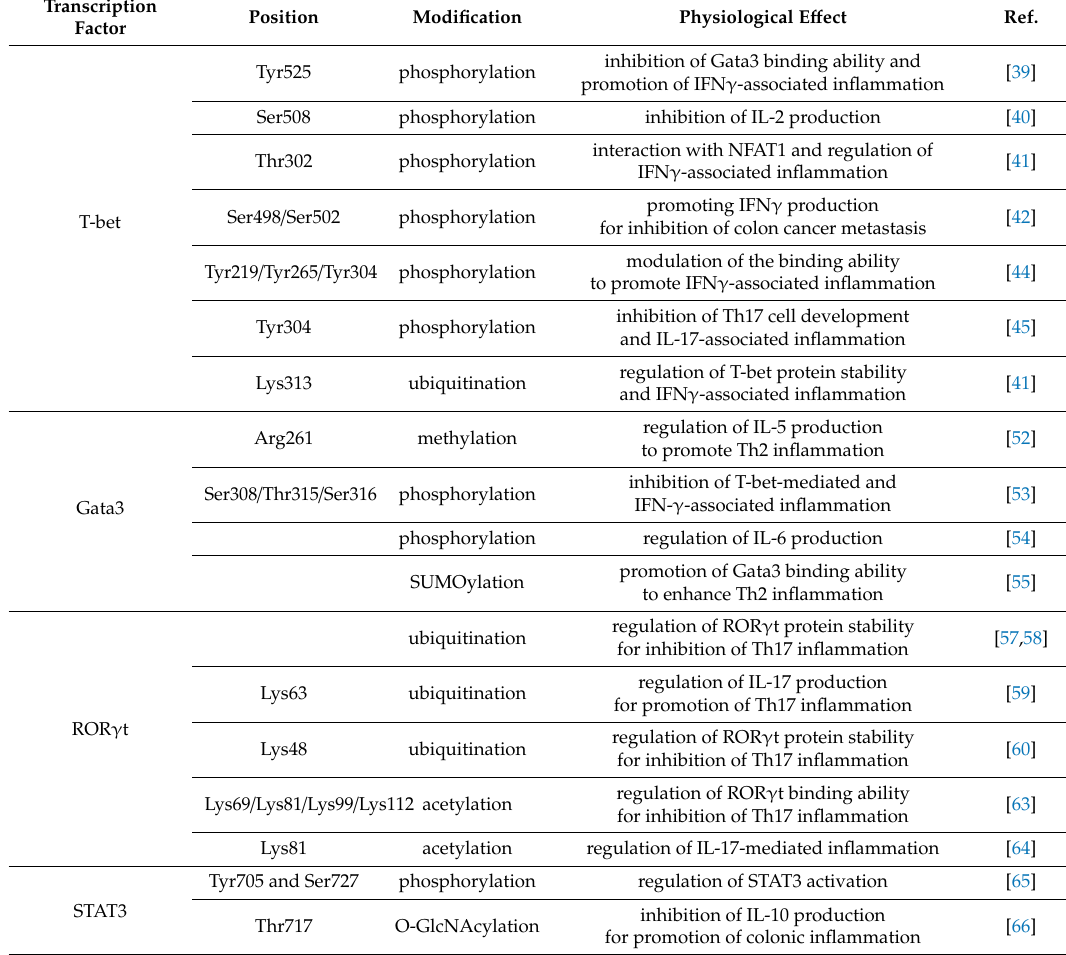
Table 1. The modulatory e ff ects of PTMs on transcription